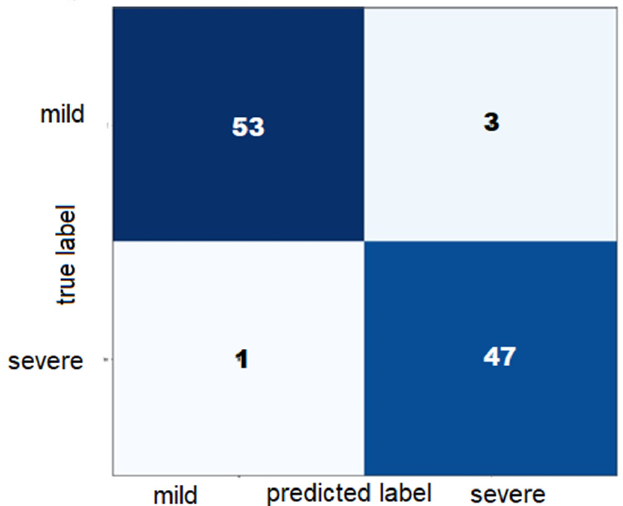
Figure 4. This figure shows training on Inception-V3 done using ADAgrad as an optimizer, which produced stable results.